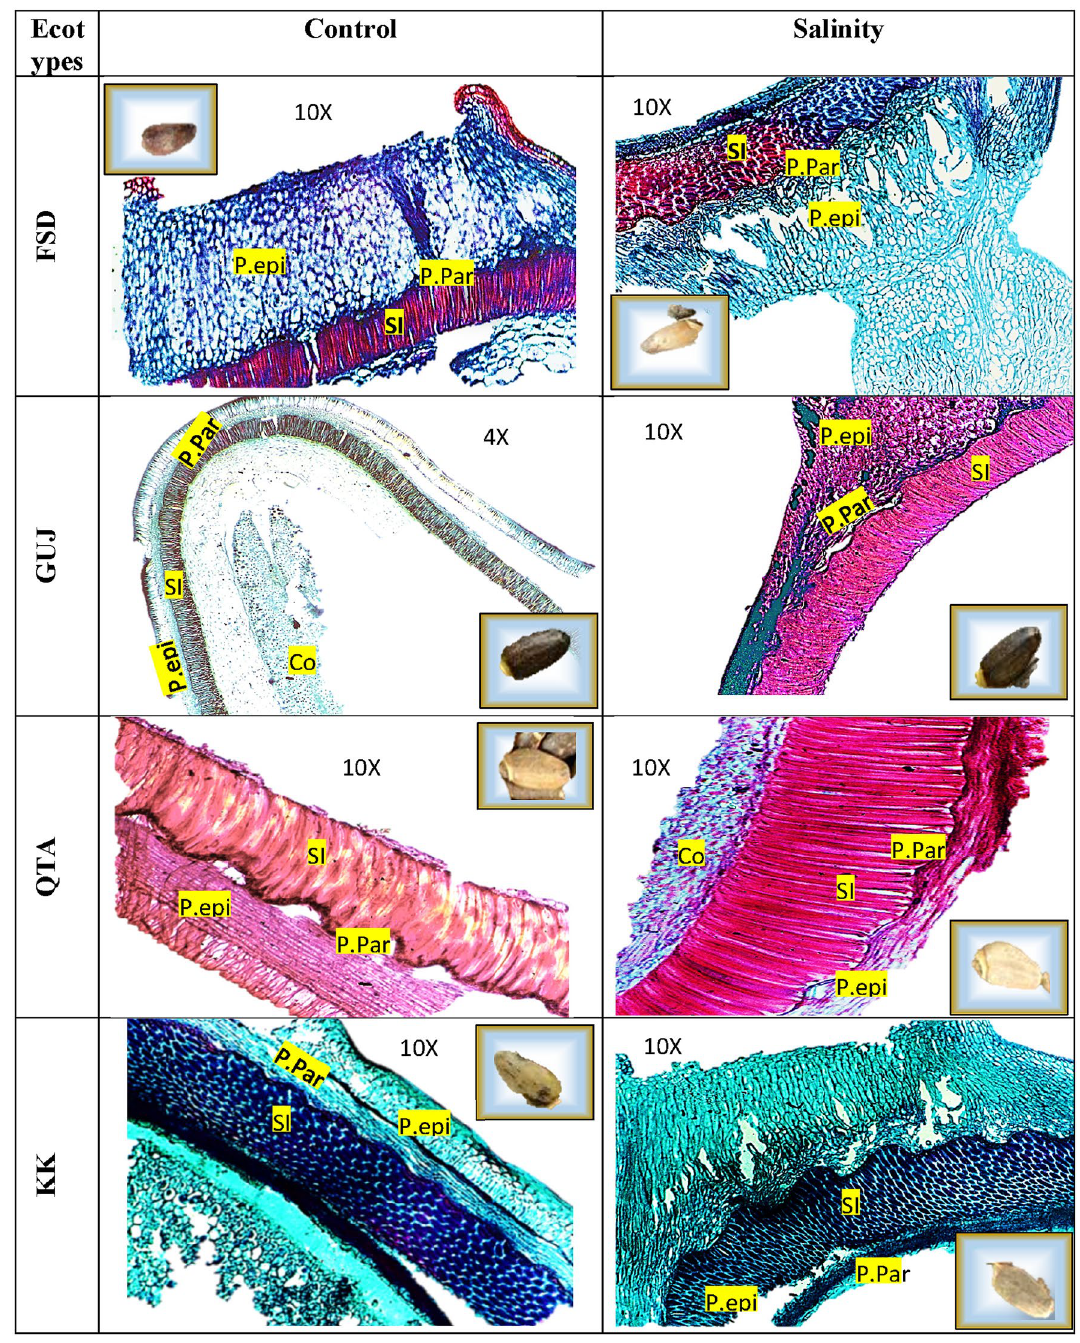
Figure 5. Elucidation of salinity stress treatment on the achene color and achene P.par and P.epi and SI length in different milk thistle ecotypes. Co, cotyledon; SI, seed integument; P-Par, pericarp parenchyma; P-epi pericarp